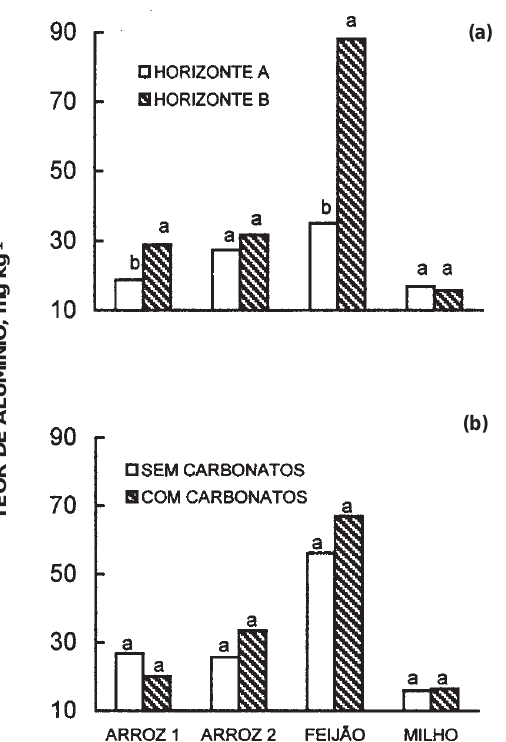
Figura 2. Teores de alumínio na parte aérea de plantas cultivadas em amostras de um Podzólico Vermelho-Amarelo do estado do Acre, influenciados (a) pelo horizonte amostrado e (b) pela aplicação de carbonatos (Arroz 1, cultivar Fernandes; Arroz 2, cultivar IAC 1131). Letras acima das barras comparam horizontes e doses de carbonatos, respectivamente, pelo teste de Tukey a